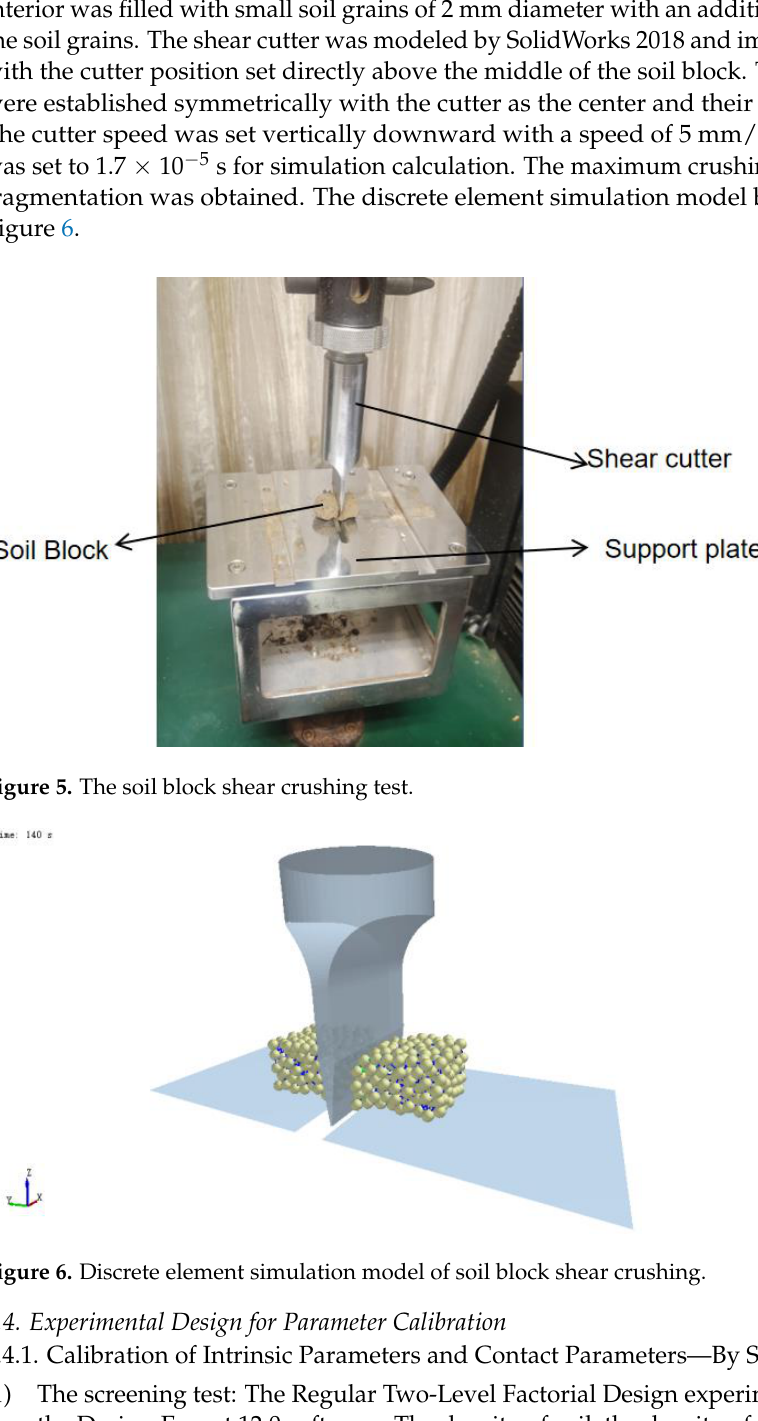
Figure 5. The soil block shear crushing test.